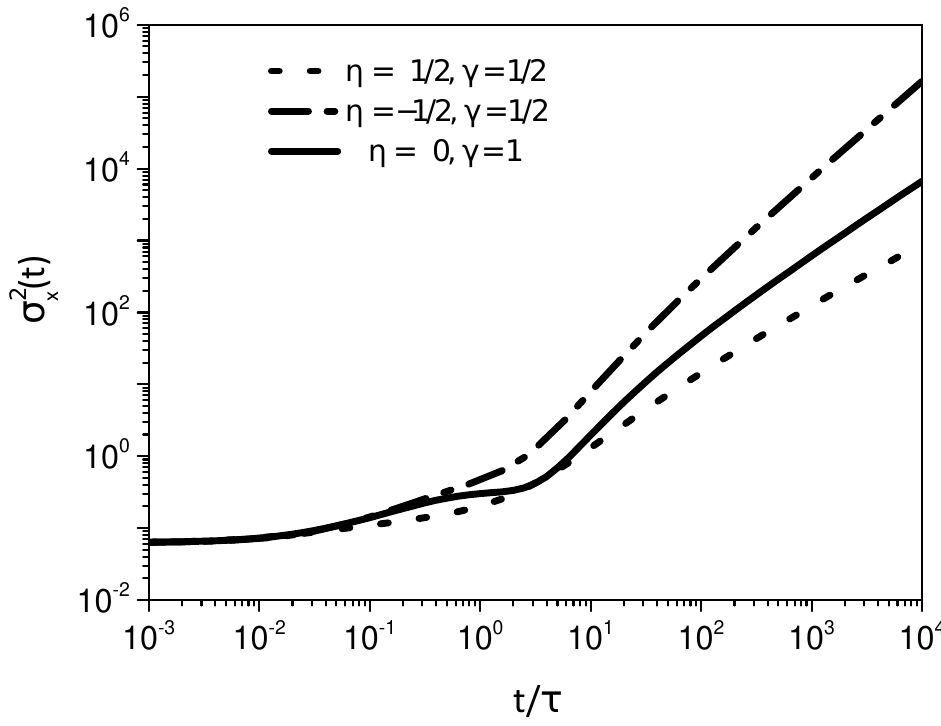
Figure 4. Behavior of the mean square displacement for different values of η and γ , where κ ( t ) = κδ ( t ) and ϕ ( x ) = δ ( x − x (cid:48) ) . It is possible to verify that the choice of η may be directly related to the asymptotic behavior of Φ ( t ) . We consider, for simplicity, ¯ κ = 1, x (cid:48) = 1/2, and D τ =